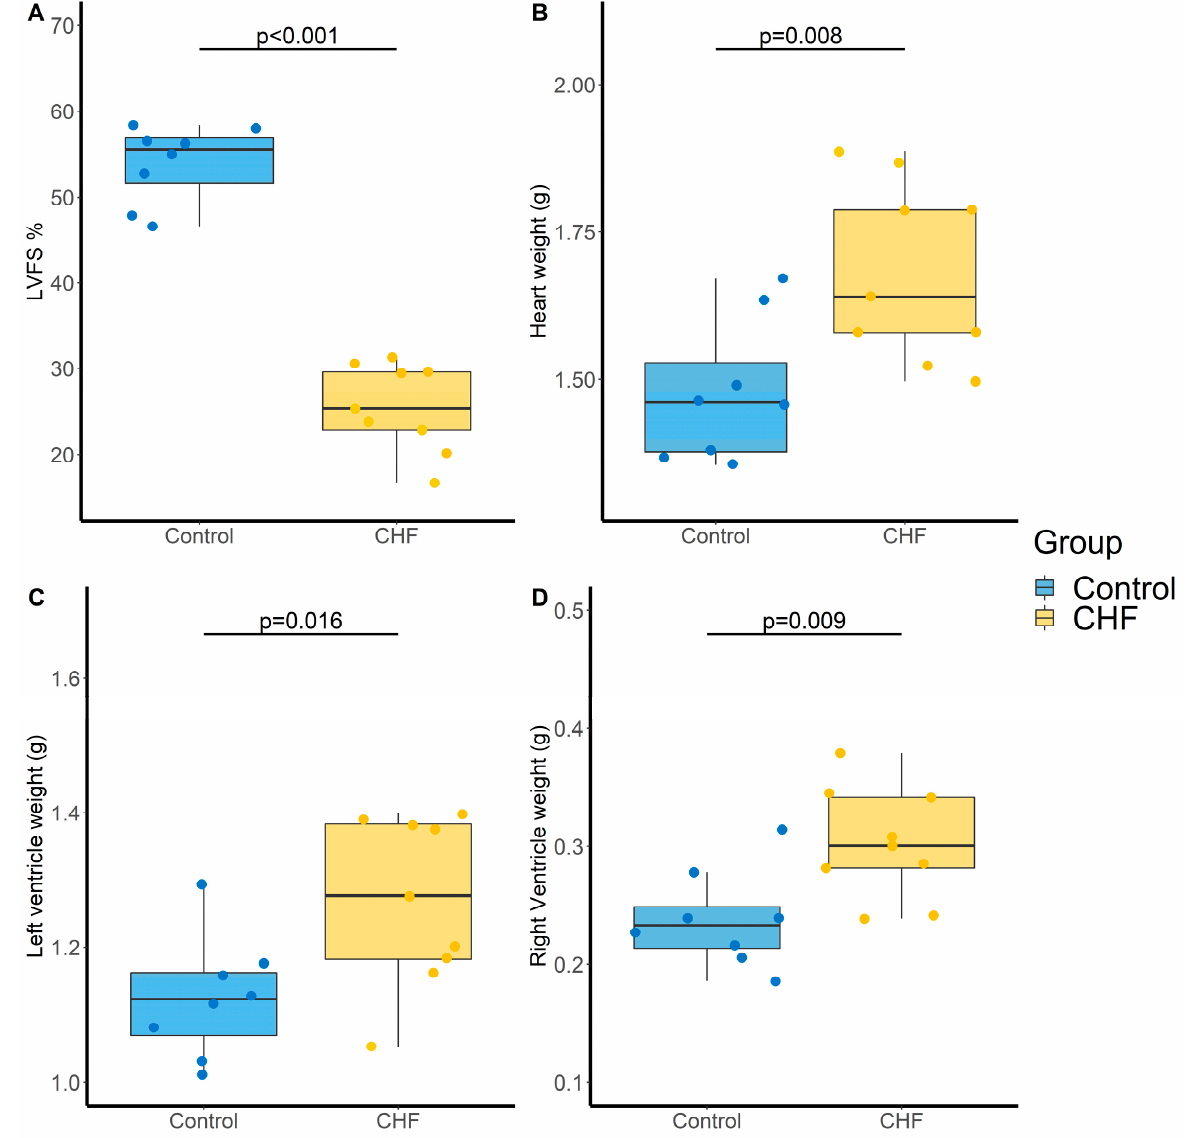
Figure 3. Evaluation of cardiac parameters in control and chronic heart failure (CHF) rats. ( A ) Left ventricular fractional shortening (LVFS, %), ( B ) Heart weight (g), ( C ) Left ventricle weight (g) and ( D ) Right ventricle weight (g). N = 8 and 9 for Control and CHF, respectively. p -values computed by Student’s t -test.